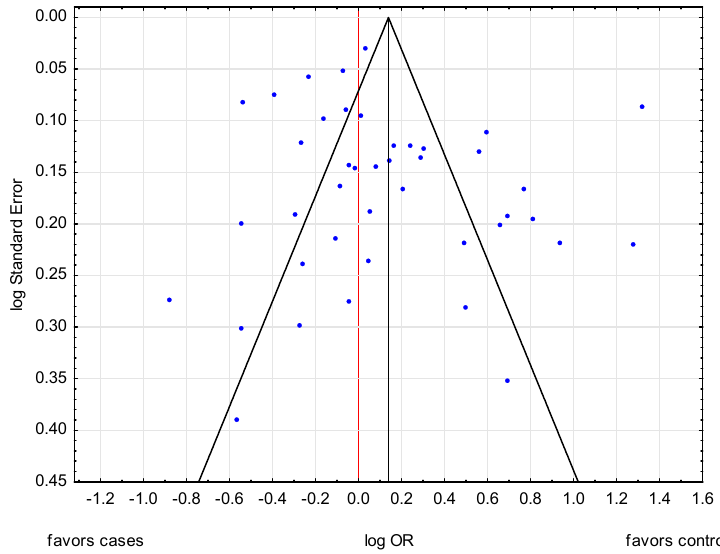
Figure 3. A funnel plot of publication bias in the meta-analysis of the relationship between BrCa risk and ever use of OC. Table 2. Analysis of the potential modifying effects of other risk factors on the relationship of OC use and BrCa risk. Variables Studies, N